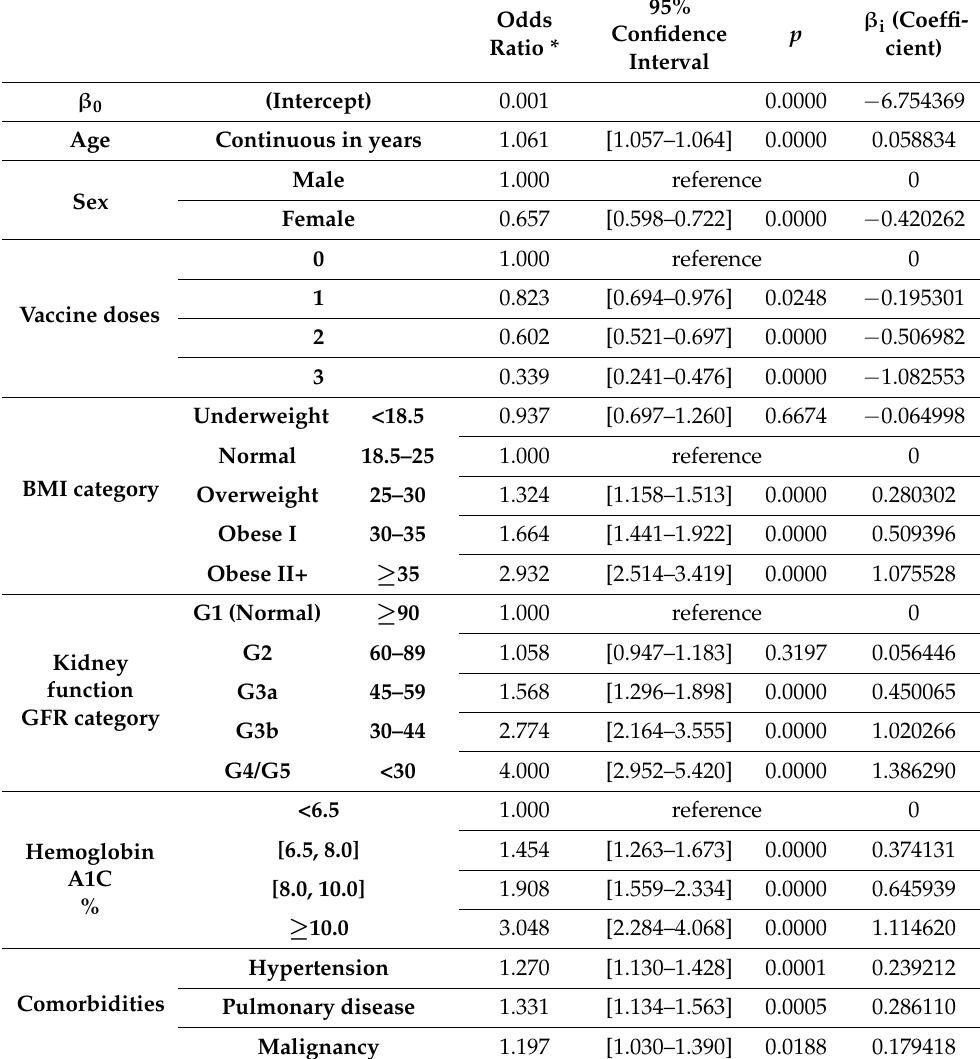
Table 2. Logistic regression model for hospitalization